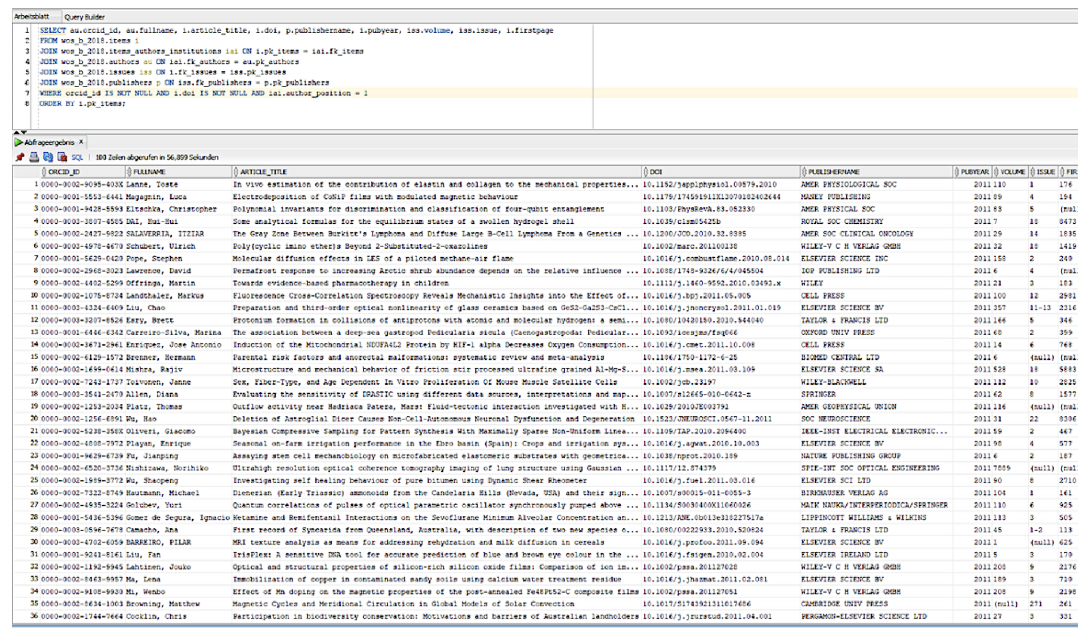
Figure 1. Example of publication data from the Web of Science